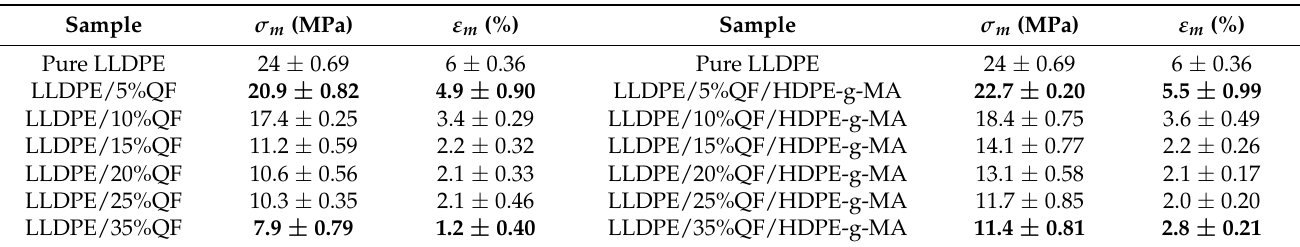
Figure 13. Young’s modulus of LLDPE/QF and LLDPE/QF/HDPE-g-MA. Table 5. Tensile strength ( σ m ) and relative elongation at maximum tensile stress ( ε m ) of LLDPE/QF and